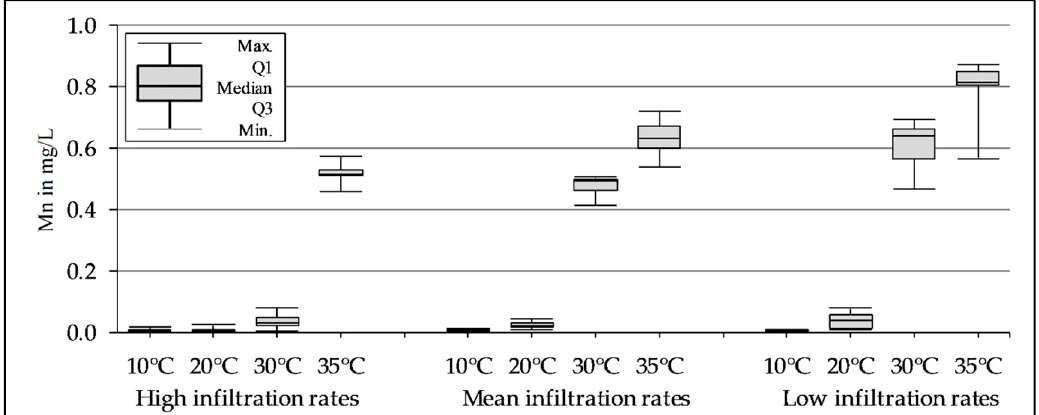
Figure 5. The mean Mn concentration in the outflow of the columns with riverbed sediment for high, mean, and low infiltration rates (4, 2 and 1 mL/min) at different temperatures (see Table S6 for no. of samples), Q 1 and Q 3 correspond to the 1st and 3rd quartile.